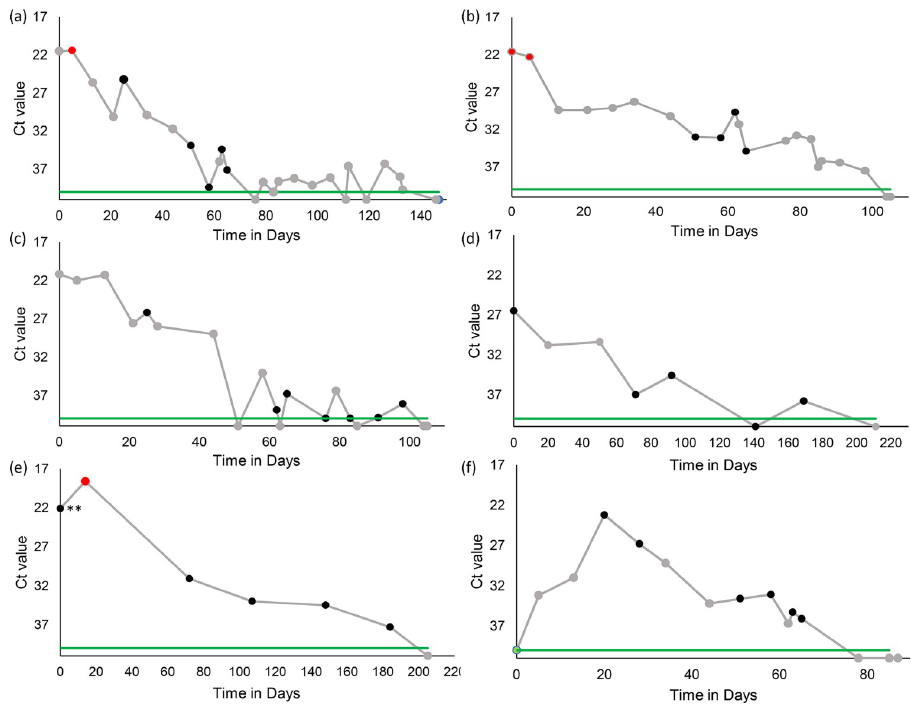
Fig 3. RT-PCR cycle threshold (Ct) over time(days) in six dogs. Graph (a) represents dog 1, (b) represents dog 2, (c) represents dog 3, (d) represents dog 4, (e) represents dog 5, and (f) represents dog 6. Red filled circles indicate samples where virus isolation was also positive. Black filled circles indicate samples where virus isolation was negative. Grey circles indicate samples where only RT-PCR testing was done. The green line demarcates the 40 cycle limit of detection. �� Indicates sample where the vial was broken and may have affected virus isolation